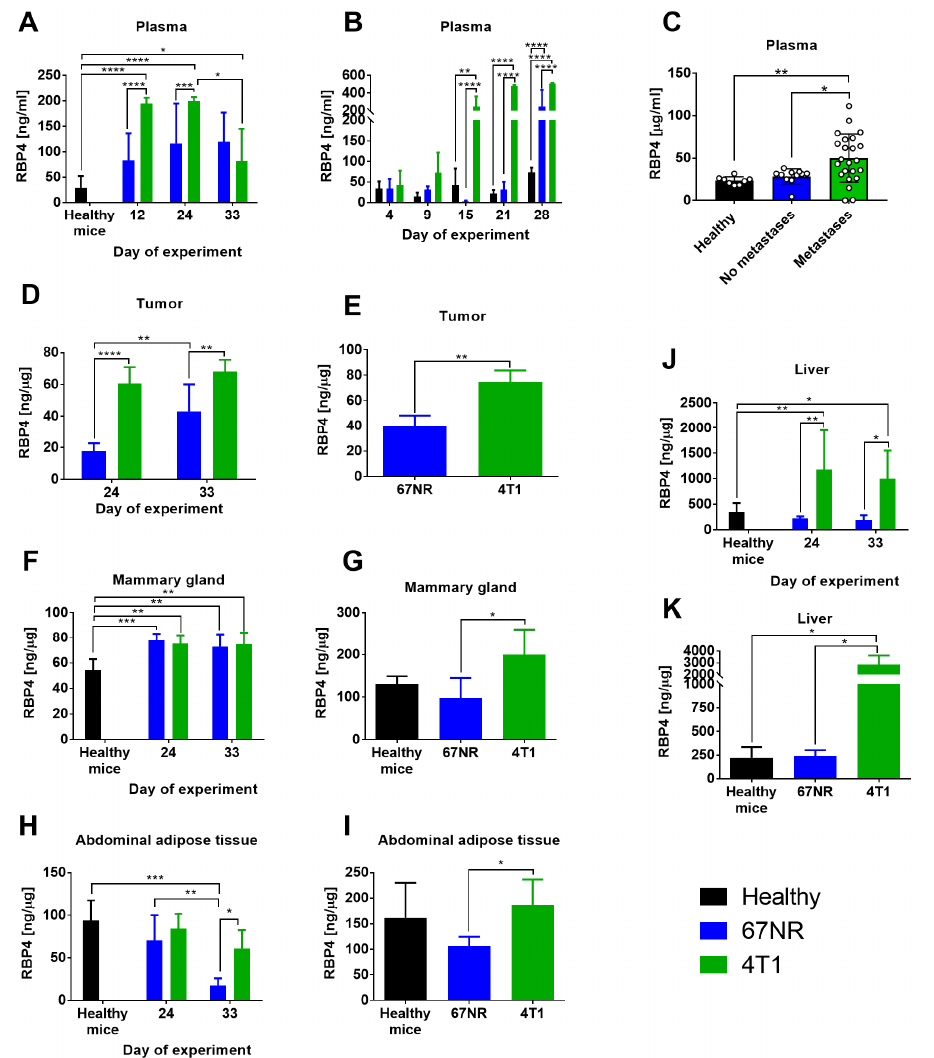
Figure 3. The level of RBP4 protein in plasma and various tissues from mice bearing nonmetastatic 67NR and metastatic 4T1 mammary gland cancer cells and in plasma from patients with breast cancer. Plasma from ( A ) young and ( B ) aged mice. ( C ) Plasma from patients with breast cancer. Tumors from ( D ) young and ( E ) aged mice. Mammary glands from ( F ) young and ( G ) aged mice. Abdominal adipose tissue from ( H ) young and ( I ) aged mice. Liver from ( J ) young and ( K ) aged mice. Data presented as mean ± SD or data for individual patients (Figure C ). Number of mice per group: ( A ) 4–5; ( B ) 4 (2 healthy mice); ( D ) 5; ( E ) 4; ( F ) 5; ( G ) 4; ( H ) 4; ( I ) 3–4; ( J ) 5; ( K ) 3–4. Statistical analysis: Tukey’s multiple comparison test * p < 0.05, ** p < 0.01, *** p < 0.001, **** p < 0.0001. The plasma level of RBP4 in patients with breast cancer was significantly higher in specimens from metastatic cancers (lymph nodes or disseminated metastases) than those in healthy volunteers the tumor tissue of young and aged 4T1 tumor-bearing mice as compared to that in 67NR tumor- bearing mice (Figure 3D,E) and in the liver tissue of 4T1 tumor-bearing mice as compared to that of control healthy mice (Figure 3J,K). In mammary gland adipose tissue from young mice, the level of